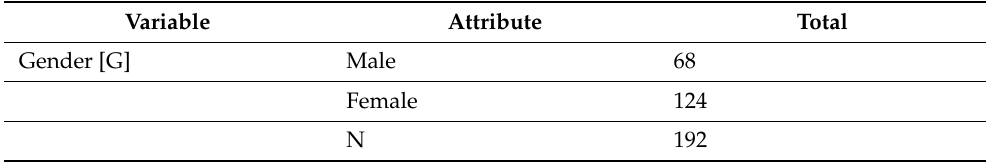
Table 2. Summary of the demographic attributes of the